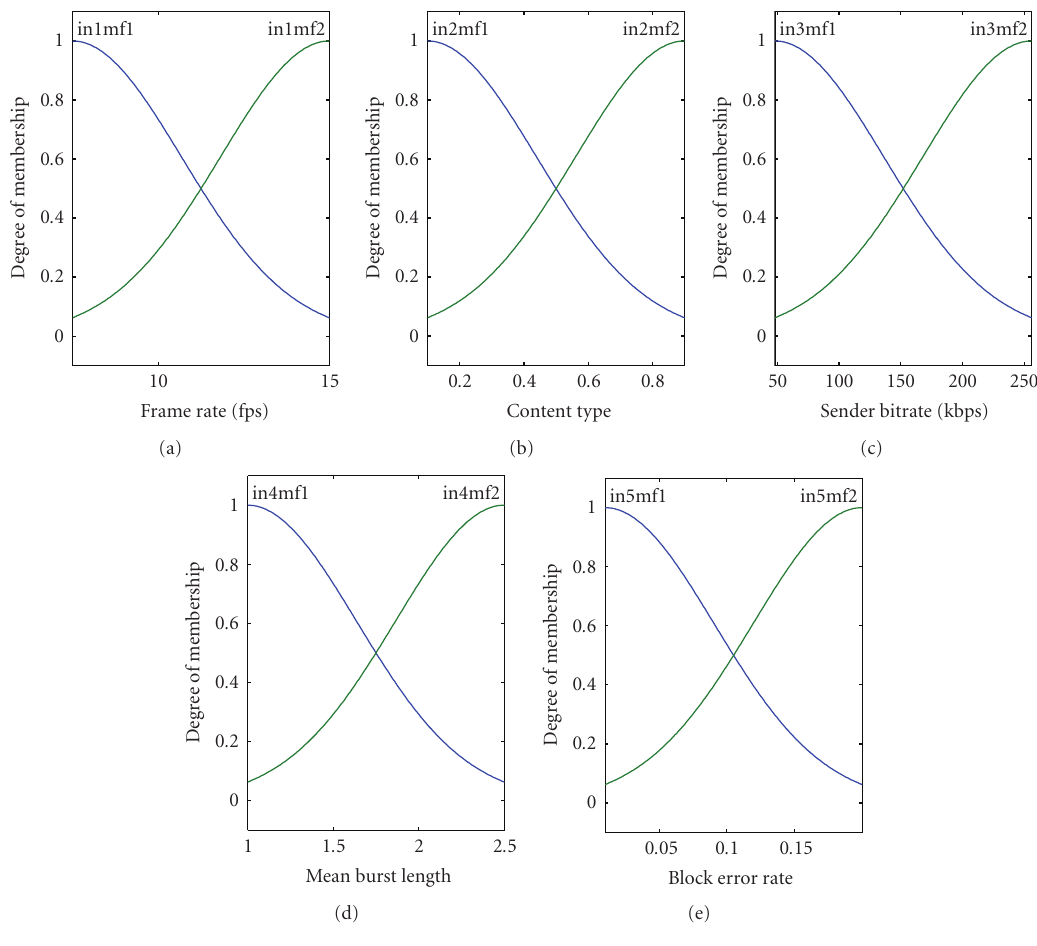
Figure 8: Membership function for the 5 selected inputs. Table 1: DL UTRAN